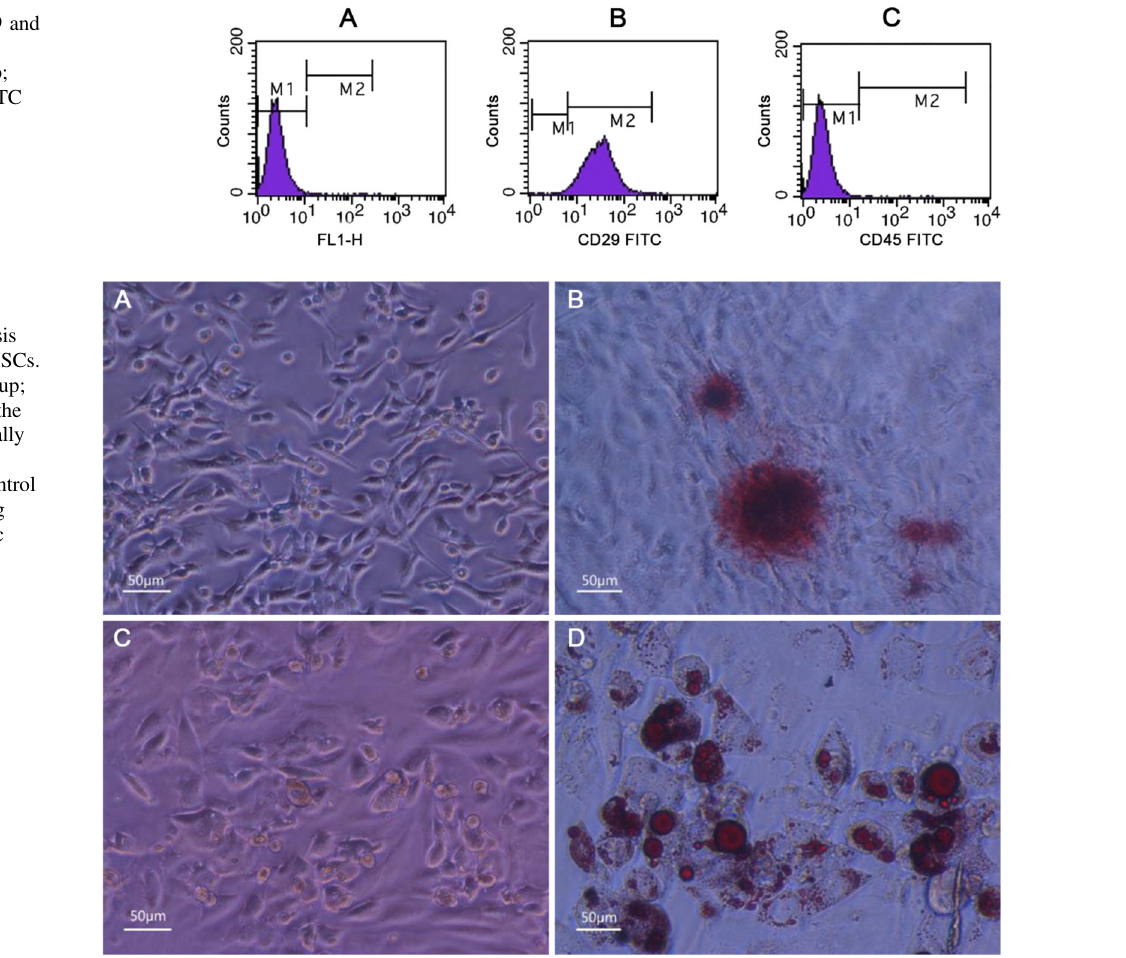
Fig. 2 Differentiation and identi fi cation of osteogenesis and adipogenicity of ADMSCs. a Osteogenesis control group; b Alizarn Red staining of the ADMSCs after osteogenically induced for 14 days. group. d Oil red O staining after 14 days of adipogenic induction